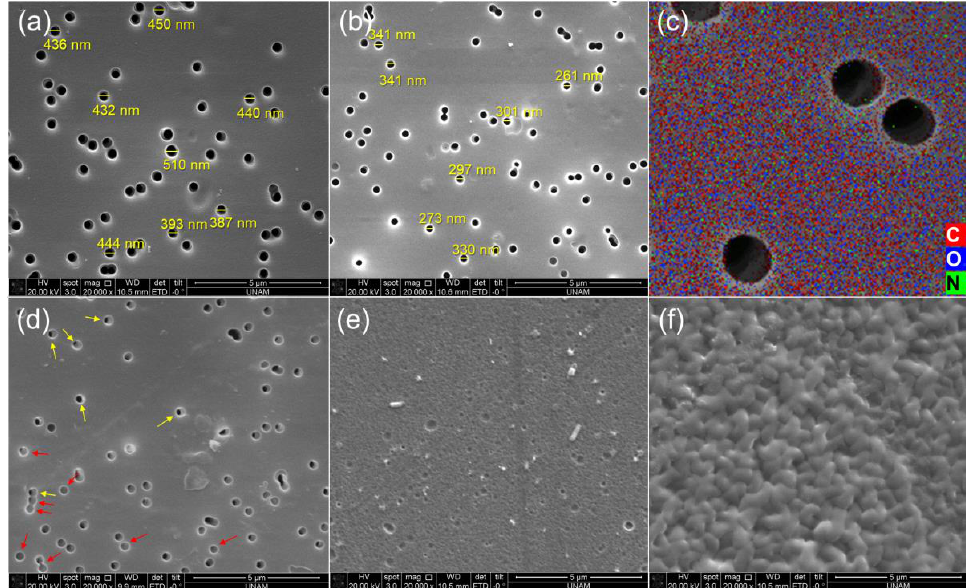
Figure 4. SEM image of pristine PET TeM ( a ), PDMAEMA- g -TeM (DG: 12%) ( b ), SEM-EDX elemental mapping for C (red), O (blue), and N (green) for PDMAEMA- g -TeM (DG: 12%) ( c ). SEM image of PDMAEMA- g -TeM (DG: 29%) ( d ), SEM image of PDMAEMA- g -TeM (DG: 35%) ( e ), and SEM image of PDMAEMA- g -TeM (DG: 22%) synthesized by a conventional method instead of RAFT-mediated grafting ( f ).